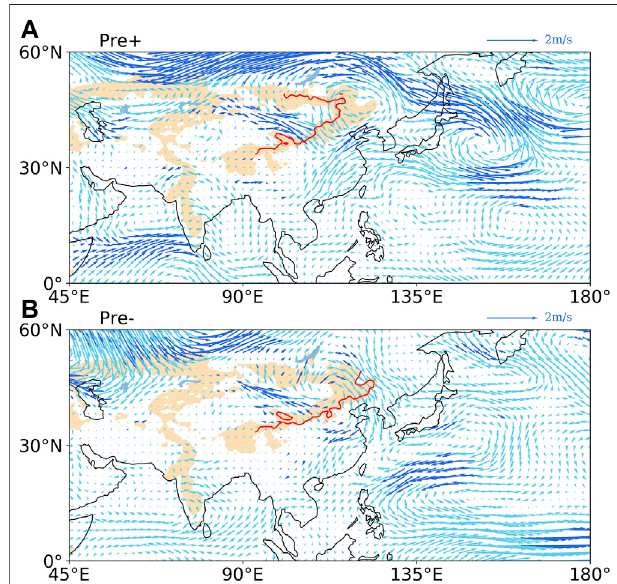
FIGURE 6 | 850 hPa summer wind composite for wet (A) and dry (B) years in the semi-arid regions of East Asia (units: m/s). The brown areas represent semi-arid areas of East Asia. The red curve represents the edge of the East Asian monsoon. The dark blue arrow denotes the region with statistical signi fi cance at the 90% con fi dence level based on Student ’ s